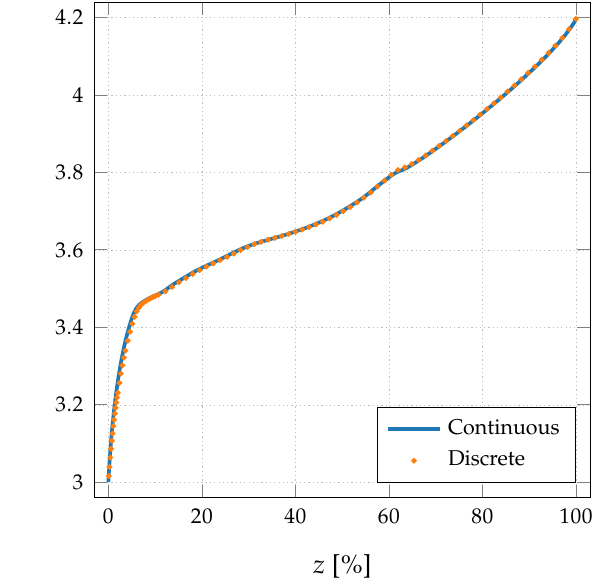
Figure 7. Comparison of the SoC-V e relation identified from both identification